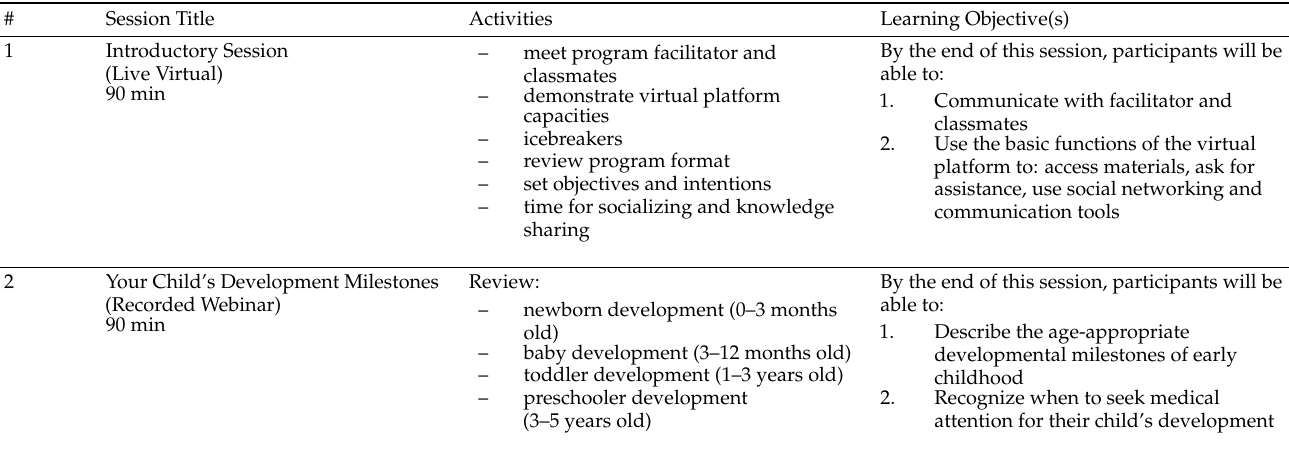
Table A1. Sample Program